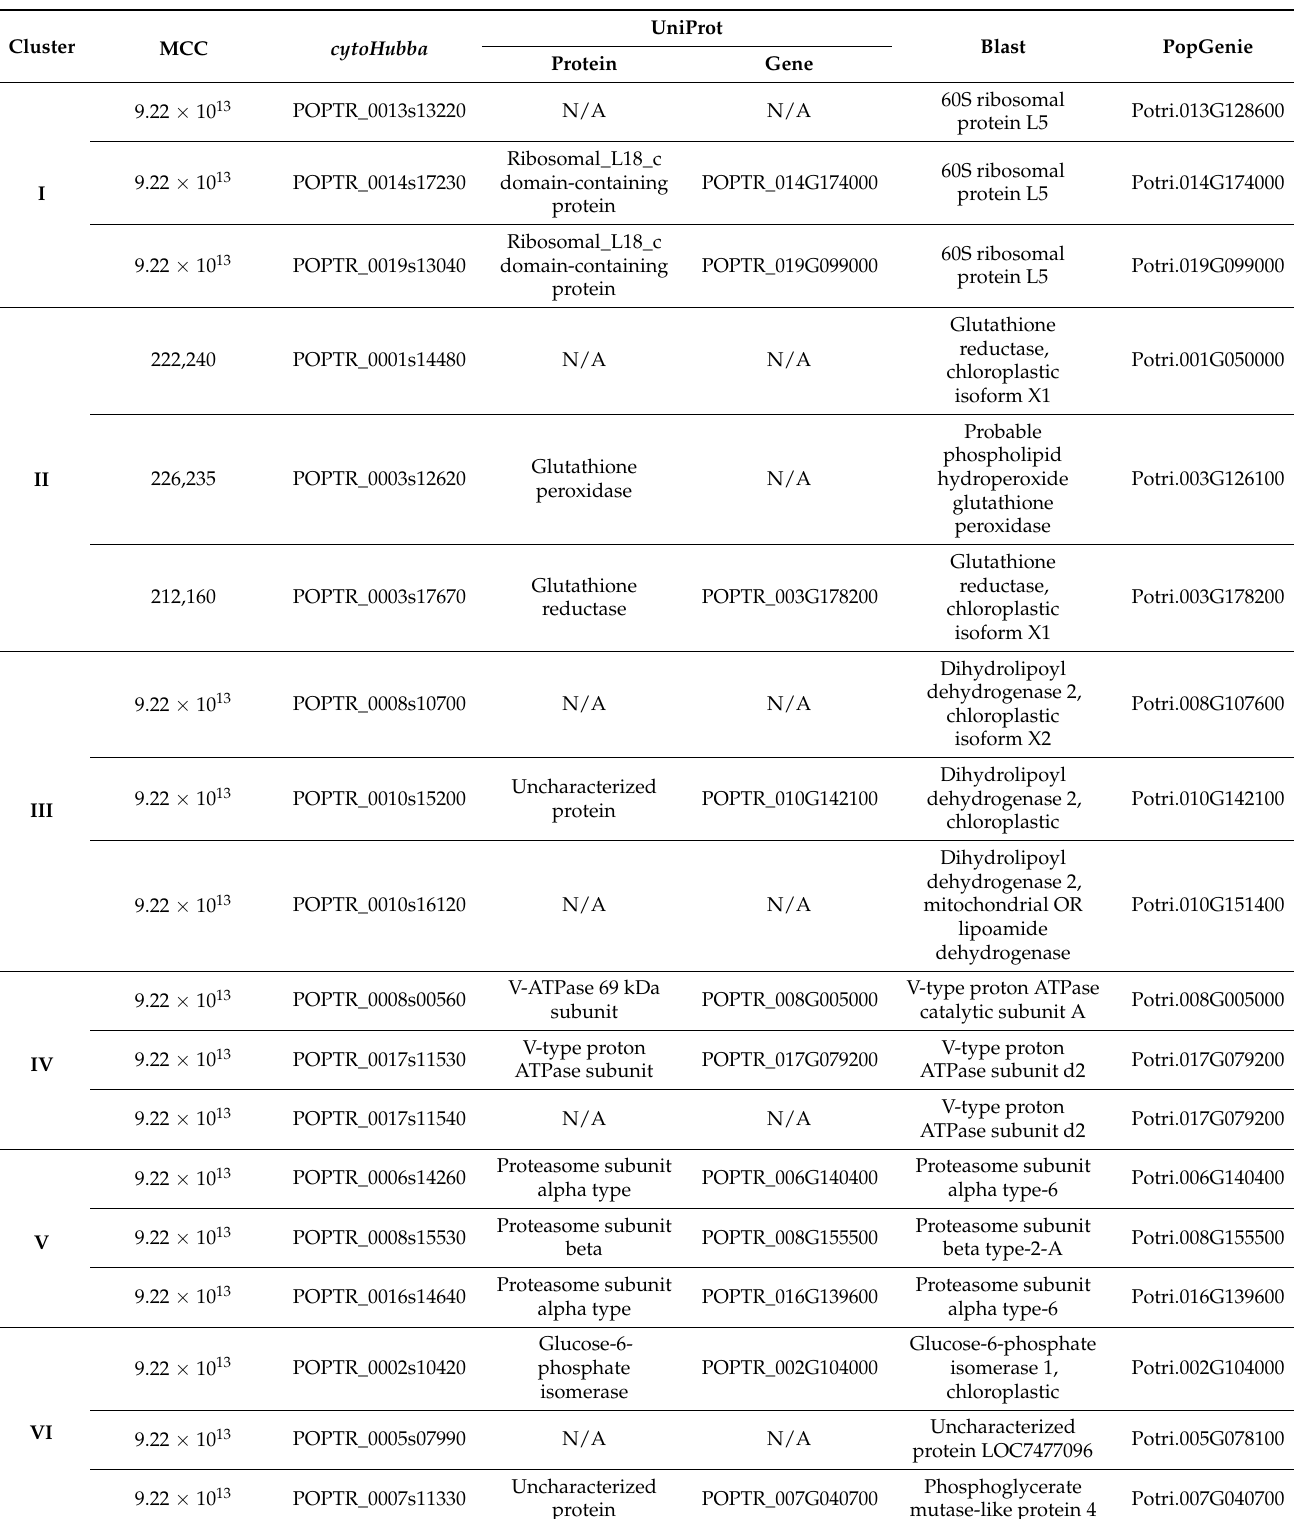
Table 3. Cluster-specific candidate hub genes. List of the top three hub genes ( cytoHubba , MCC algorithm) of each cluster-related subnetwork (I–VI), explored through UniProt [38], Blast [39], and PopGenie [40]